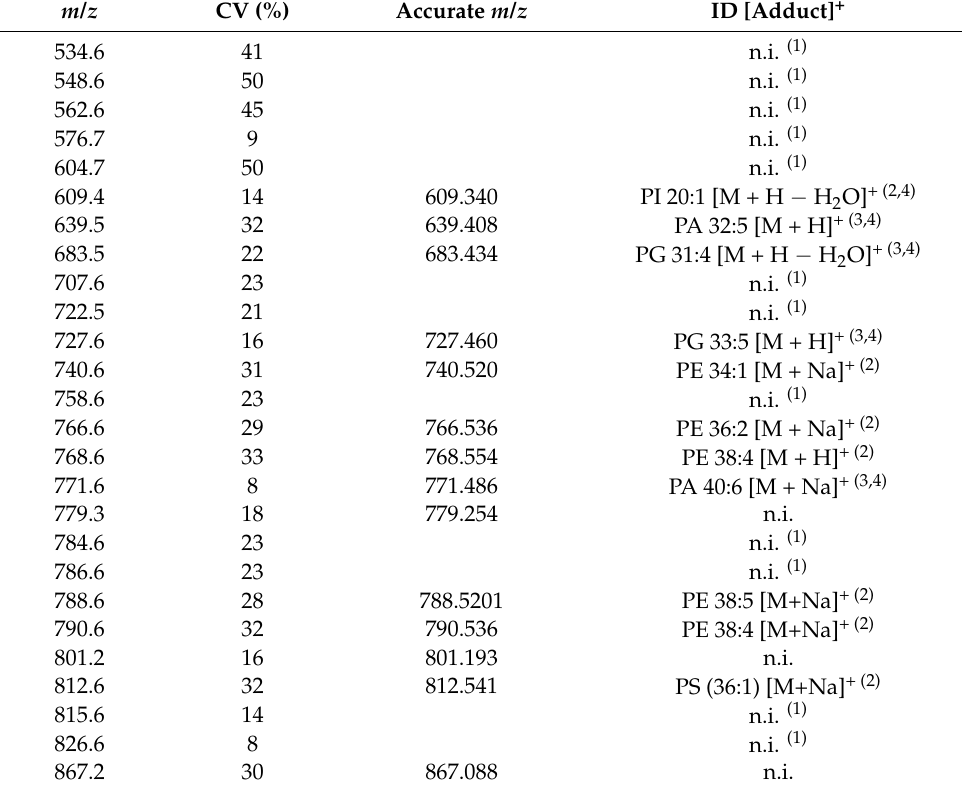
Table 1. Master peak list with m/z values, corresponding coefficients of variation (CV), accurate m/z values and chemical identification (ID). CV was calculated for the three technical replicates of the whole dataset (treated n = 4 and control n =